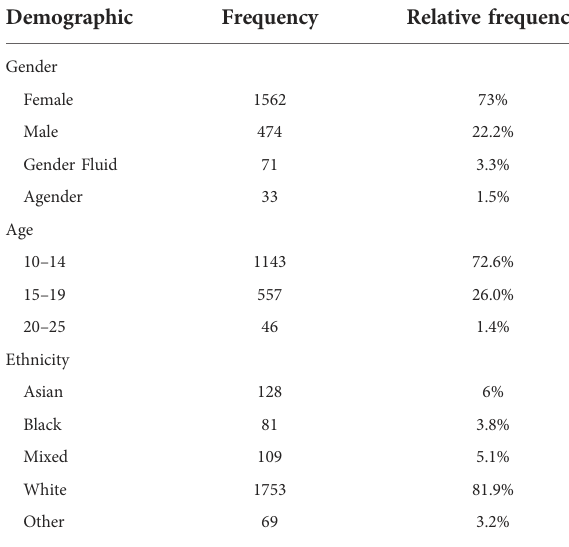
TABLE 7 Demographic characteristics and frequencies of unique users completing POCEMs.